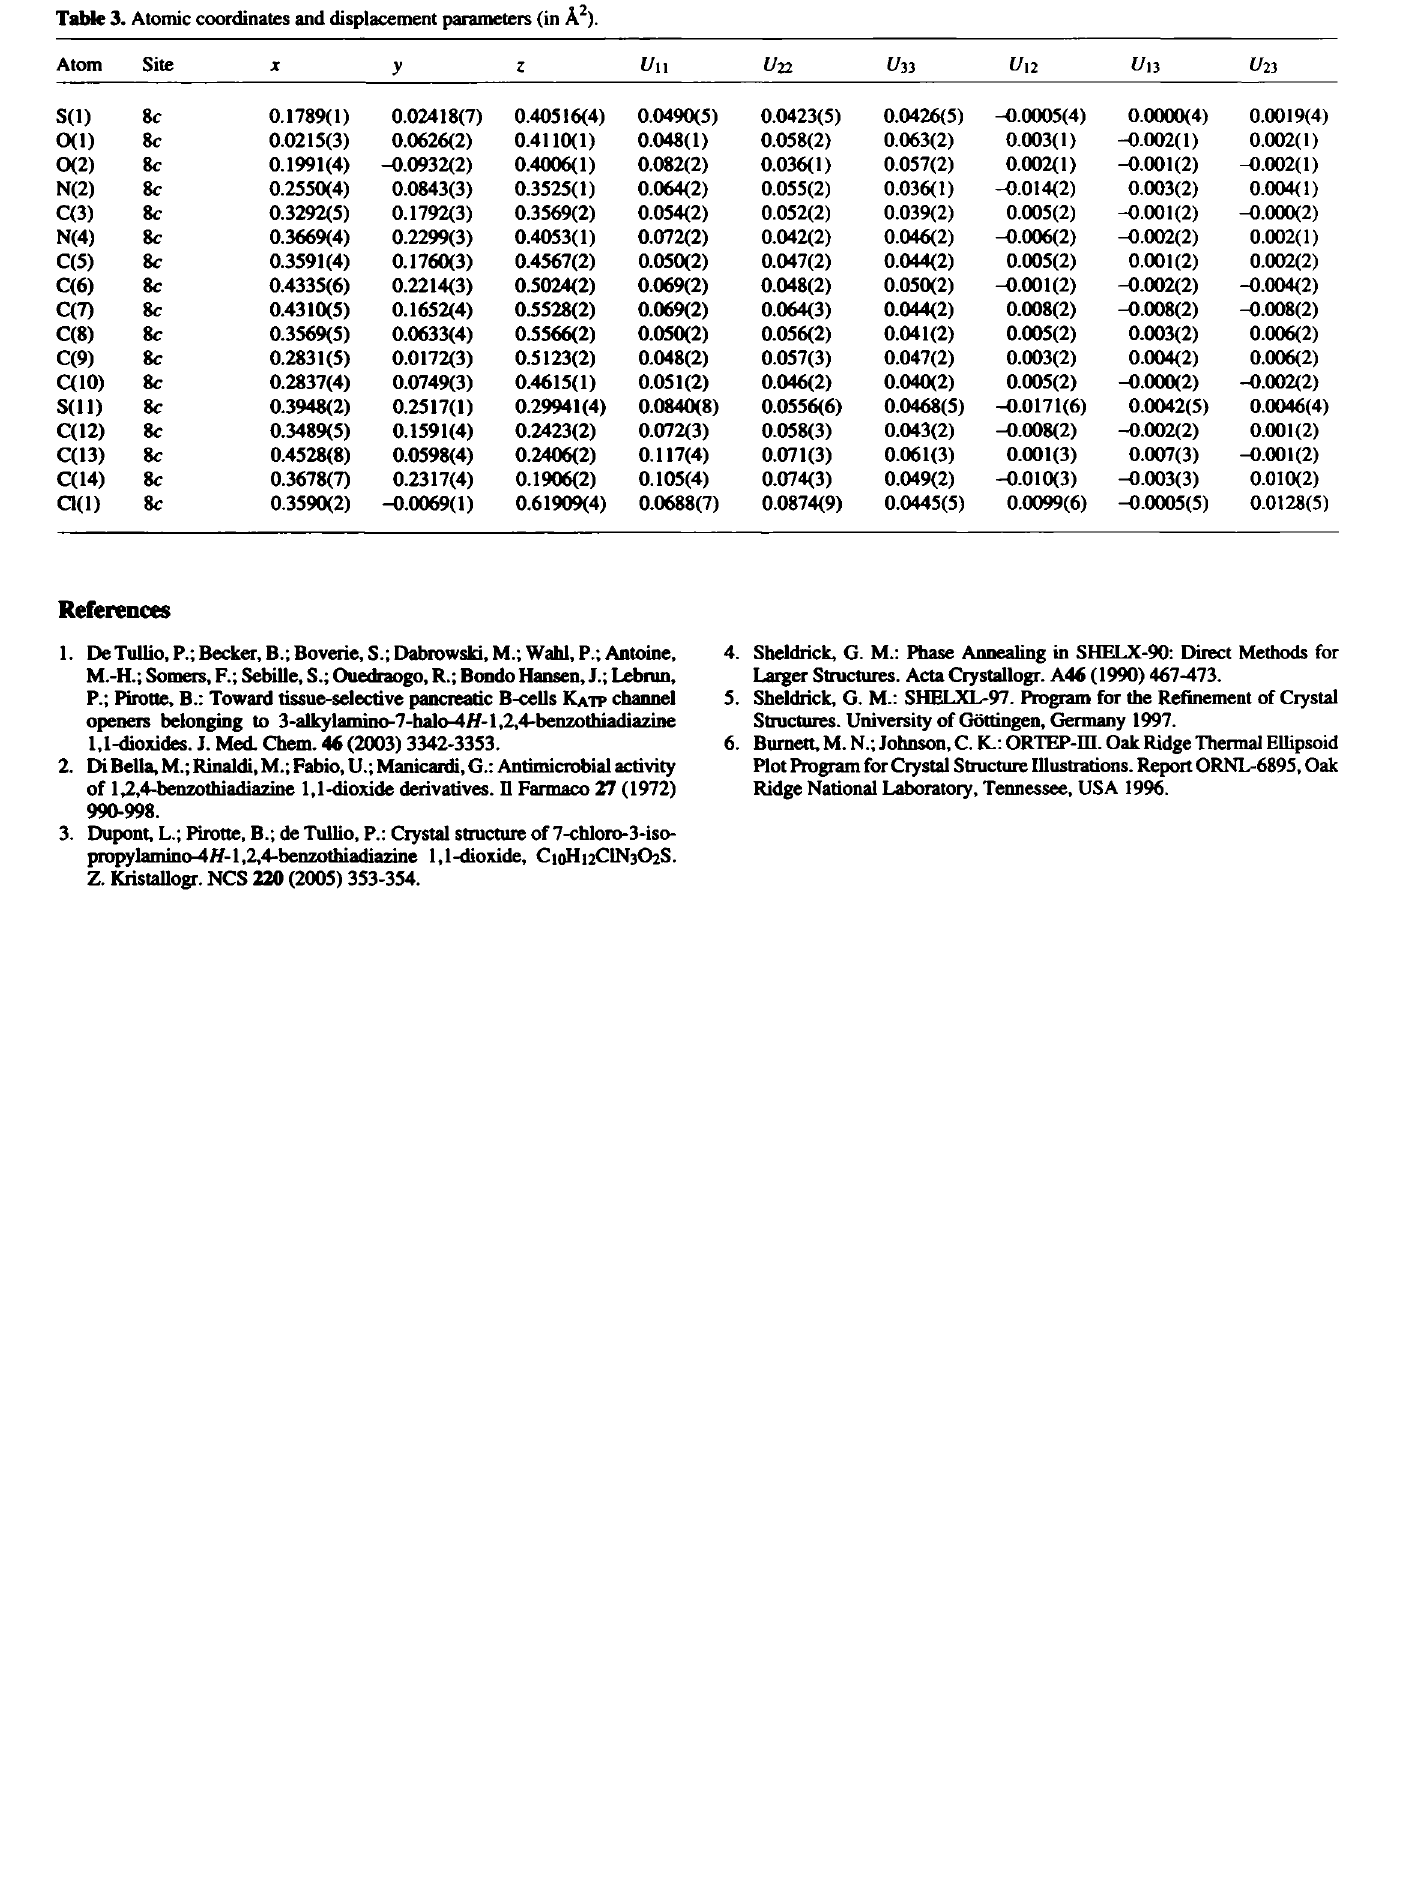
Table 3. Atomic coordinates and displacement parameters (in A 2